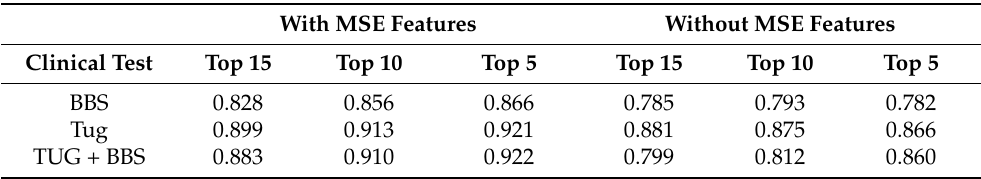
Table 6. Average AUC classification scores with and without